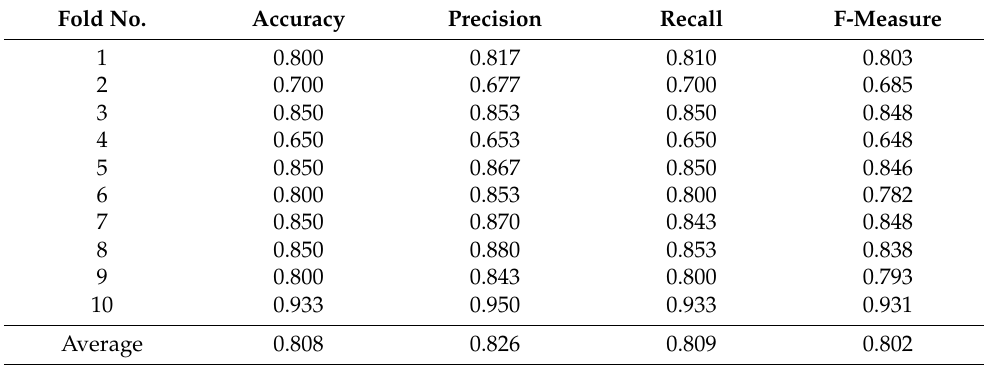
Table 11. Accuracy, precision, recall, and F-measure of Xception model (male-only). Fold